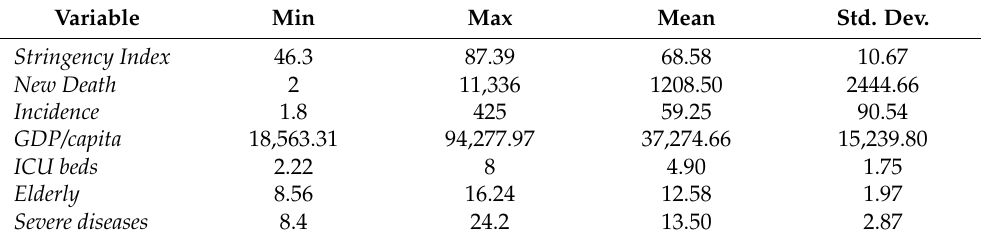
Table 2. Descriptive statistics.